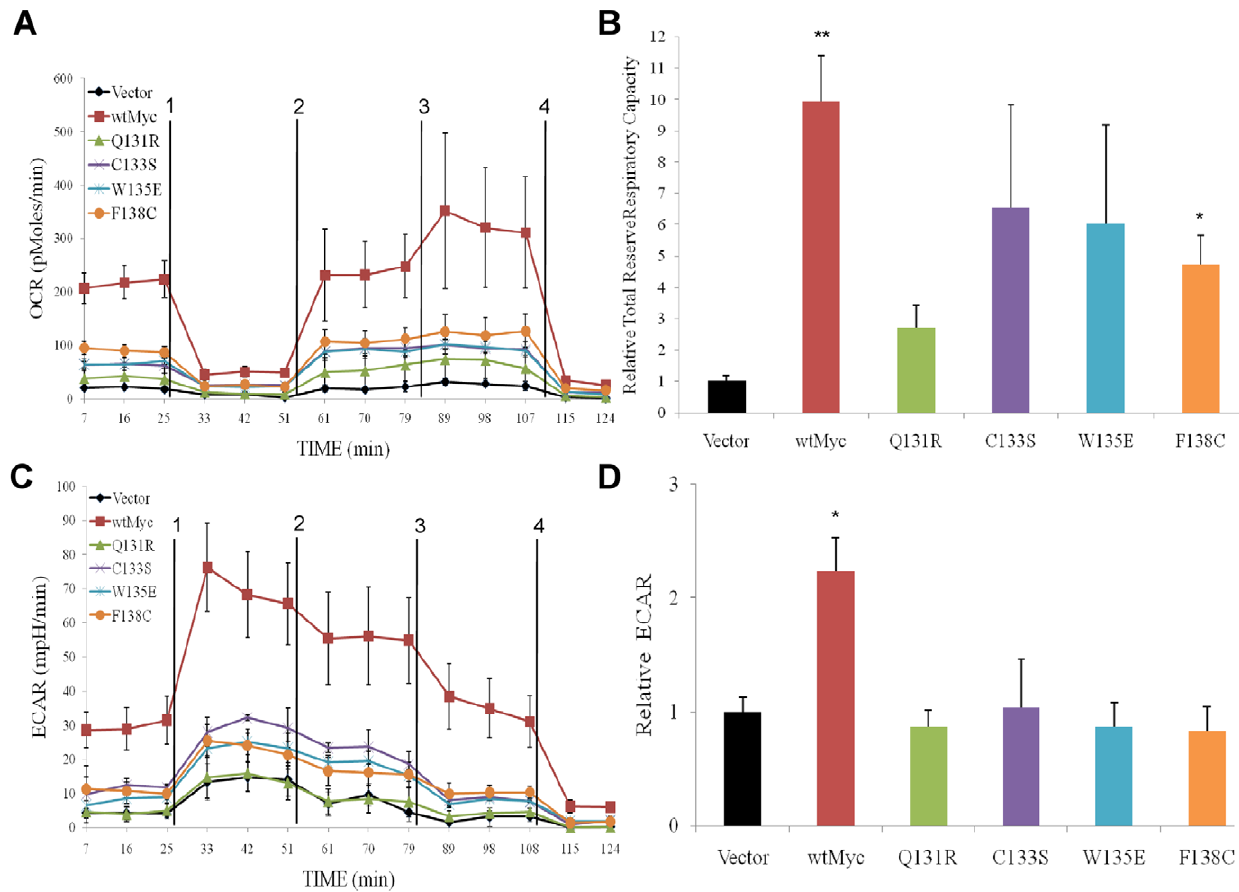
Figure 5. OCR and ECAR in Rat1a cells expressing human Myc point mutants. ( a ) A Seahorse Bioscience XF24 Extracellular Flux Analyzer was used for the real-time determination of metabolism. OCR (OXPHOS) was expressed as a function of time. Each inhibitor as described in Results was injected at the times indicated by the vertical lines (injections 1–4). A typical experiment, performed in triplicate wells is shown. The experiment was repeated on at least three occasions with similar results. ( b ) Areas under the curve (AUC) were calculated with the software provided by the manufacturer and used to compare the various cell lines’ total reserve respiratory capacity relative to that of vector control cells, which are arbitrarily set at 1. The average of three to five individual experiments, where each cell line was measured at least in triplicate is displayed + / 2 1 SE. p-values of the comparisons with vector control cells were calculated by a two-tailed t-test in Microsoft Excel: (*) p # 0.05; (**) 0.01. This graph represents the AUCs for the time point just prior to injection 2 until the time point just before injection 4. This represents the total reserve respiratory capacity of each cell line. ( c ) ECARs (glycolysis) were expressed as a function of time. The vertical lines represent the same injections as previously described. The experiment was repeated on at least three occasions with similar results. ( d ) AUCs for the time point just prior to injection 1 to the time point just prior to injection 2 were calculated. This is the best representation of the glycolytic potential of these strains. p-values were calculated and represented as described for ( b